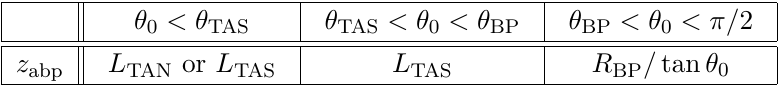
Table 3 . A summary of the integration interval of z 0 . The angles θ TAS and θ BP are defined as θ TAS = arctan ( R TAS /L TAS ) and θ BP = arctan ( R BP /L TAS ) , respectively. In the case of θ 0 < θ TAS , we choose z abp = L TAN for neutral mesons, while z abp = L TAS for charged